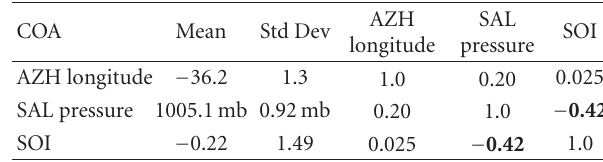
Table 2: Columns 2 and 3 give the mean values and standard deviations of COA indices related to Sahel precipitation, and columns 4, 5, and 6 are their mutual correlations. The Azores High and South Asia data are for 1948–1998, and the SOI values are for